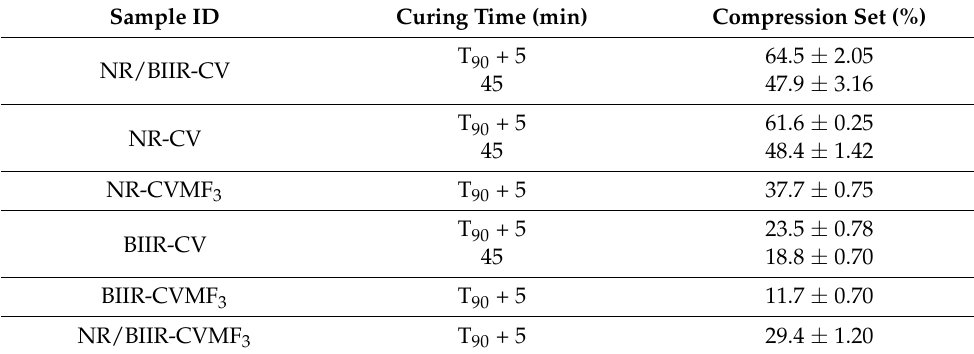
Table 4. Compression set